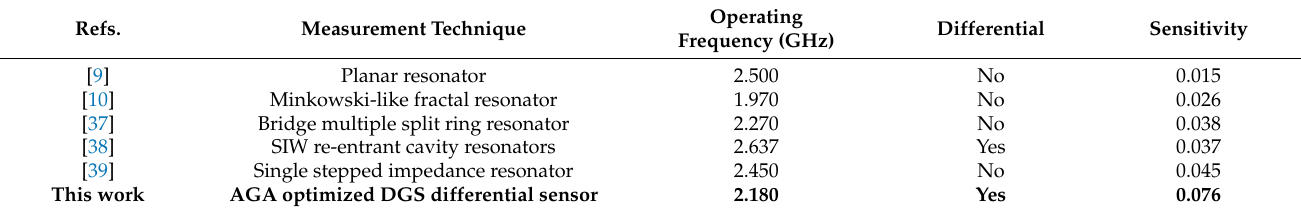
Table 4. Compared results of the proposed sensor with other published